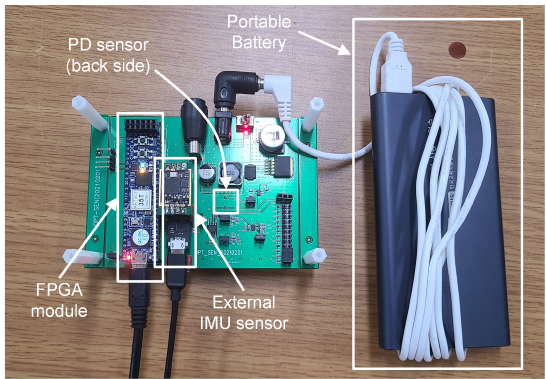
Figure 10. Receiver module (PD, IMU